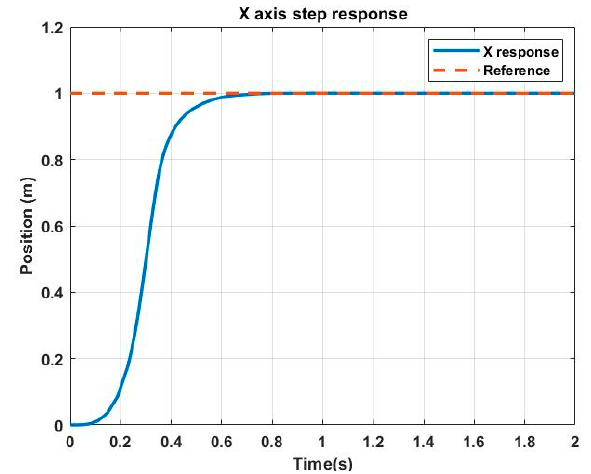
Figure 5. System response in X axis. Electronics 2020 , 9 , x FOR PEER REVIEW